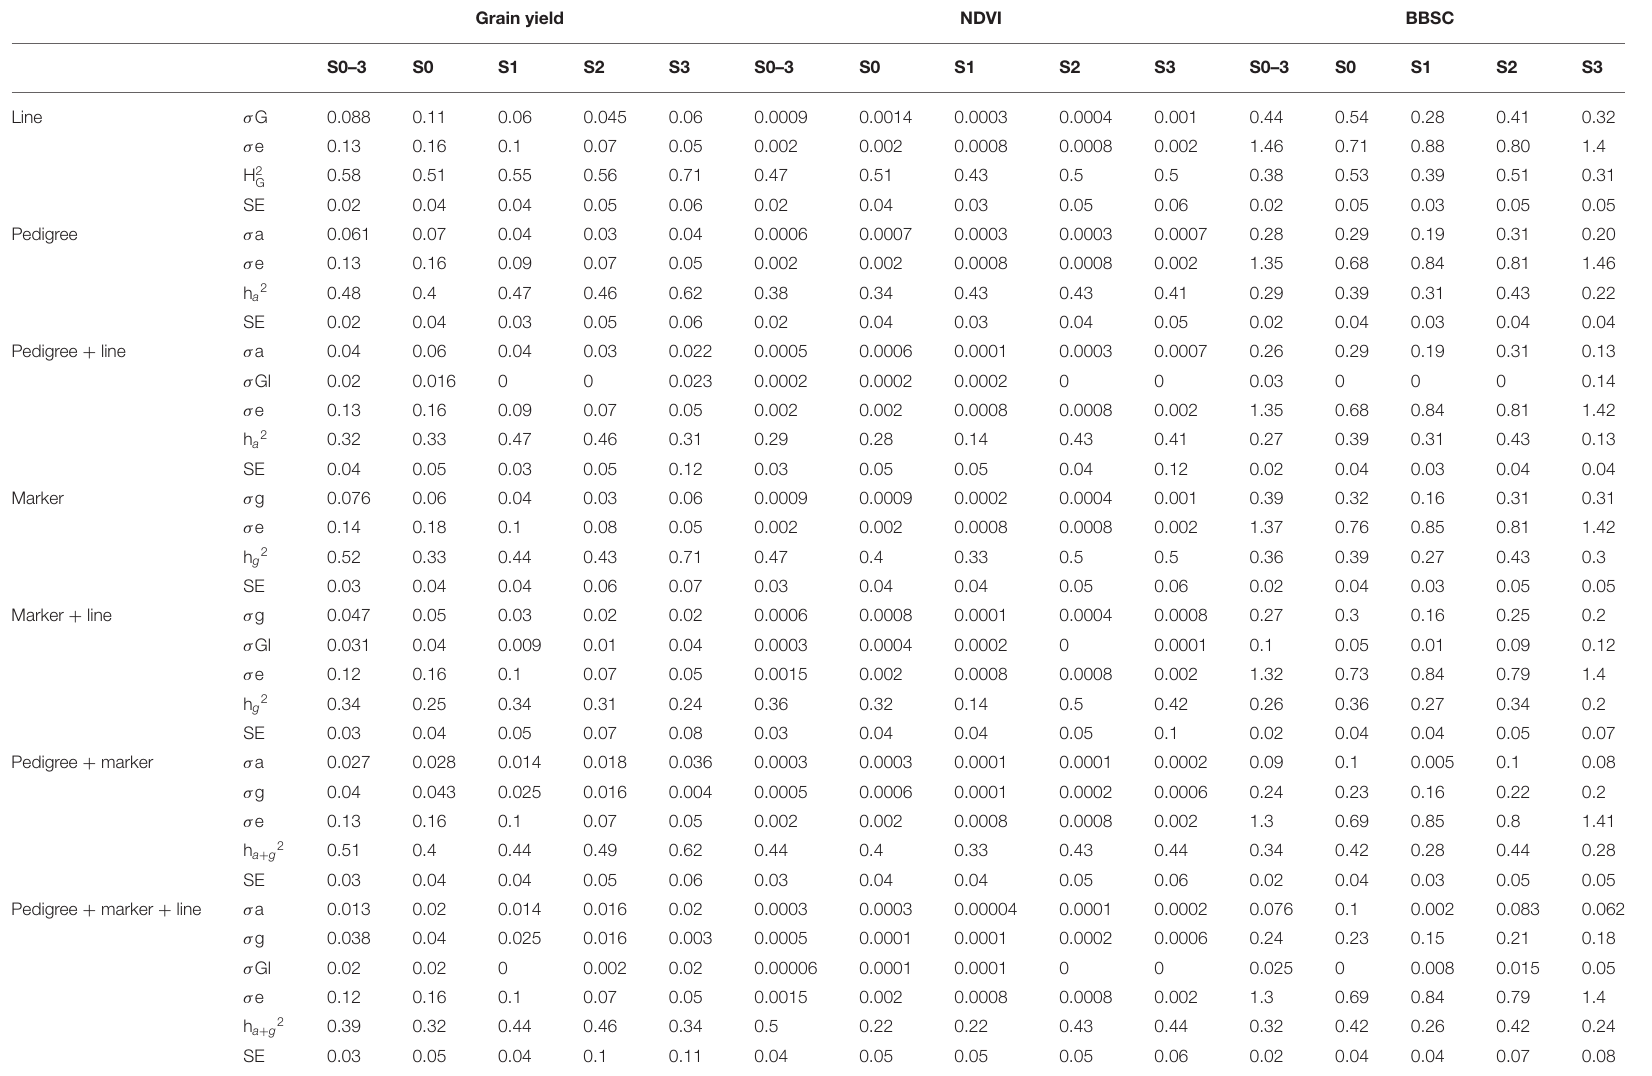
TABLE 1 | Total genetic variance ( σ 2 G ), additive genetic variance ( σ 2 a or σ 2 g ), and non-additive genetic variance ( σ 2 Gl ) of grain yield, NDVI, and BBSC at each breeding stage, and broad (H 2 ) and narrow-sense heritability (h 2 ) and their standard error (SE) from model 1—univariate models. Grain yield